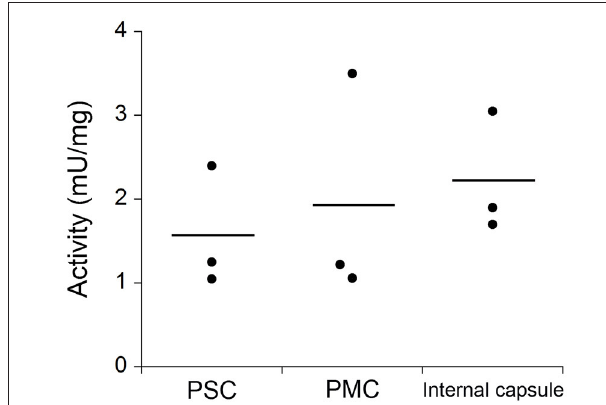
FIGURE 10 | Comparison of DAAO activity in different human CNS samples determined by catalase and Purpald ® coupled assay: primary somatosensory cortex (PSC), primary motor cortex (PMC), and the posterior limb of internal capsule. DAAO activity is expressed as milliunits per milligram of total proteins (mU/mg). Statistical analyses were performed with ANOVA, n = 3. Figure obtained on the basis of the results published in Sasabe et al. (2014).